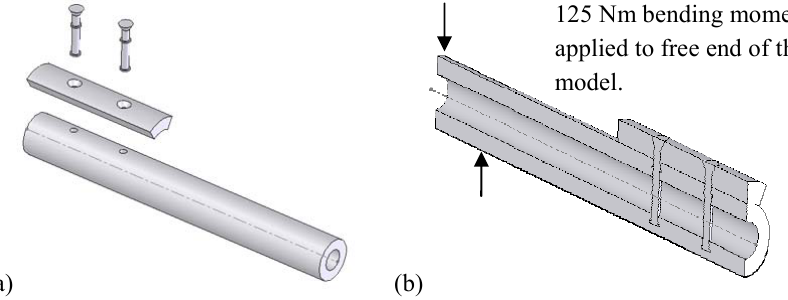
Fig.2 Parametric model geometry (a) Exploded view, ( sults alidation model